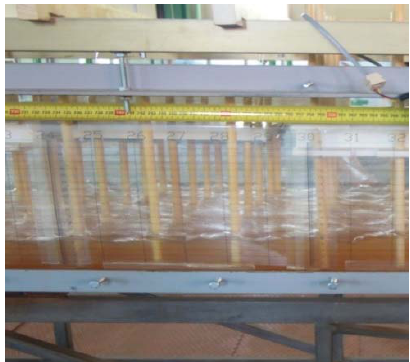
Figure 2. Laboratory flume with arrays of cylinders representing rigid vegetation, University of Calabria.